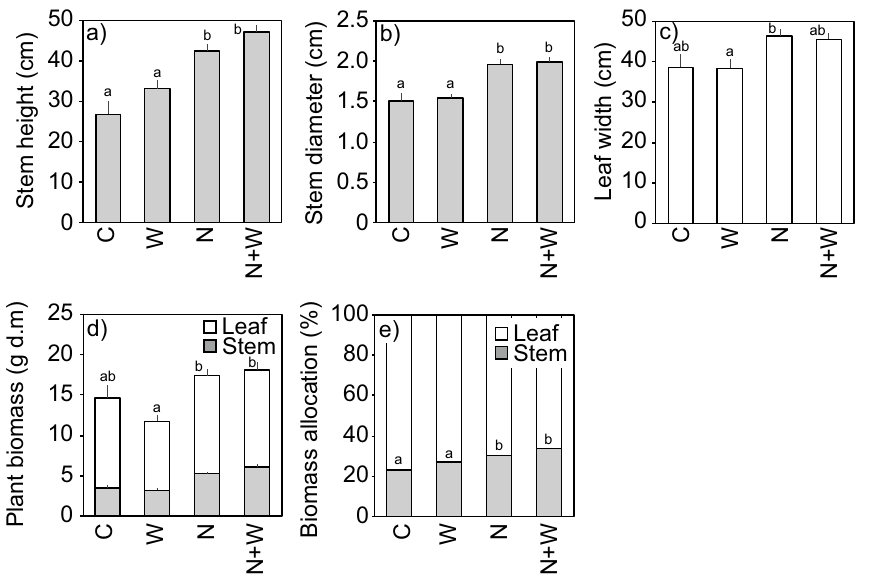
Figure 4. ( a ) Stem height, ( b ) stem diameter, ( c ) leaf width, ( d ) plant biomass, and ( e ) biomass allocation of butterburs grown under the conditions of the control (C), addition of water (W), addition of nutrients (N), and addition of nutrients and water (N + W). Bars represent standard errors [ n = 8 (C), 9 (W), 8 (N), 8 (N + W)]. Different letters indicate significant differences at P < 0.05 (Tukey’s honest significant difference test) among the